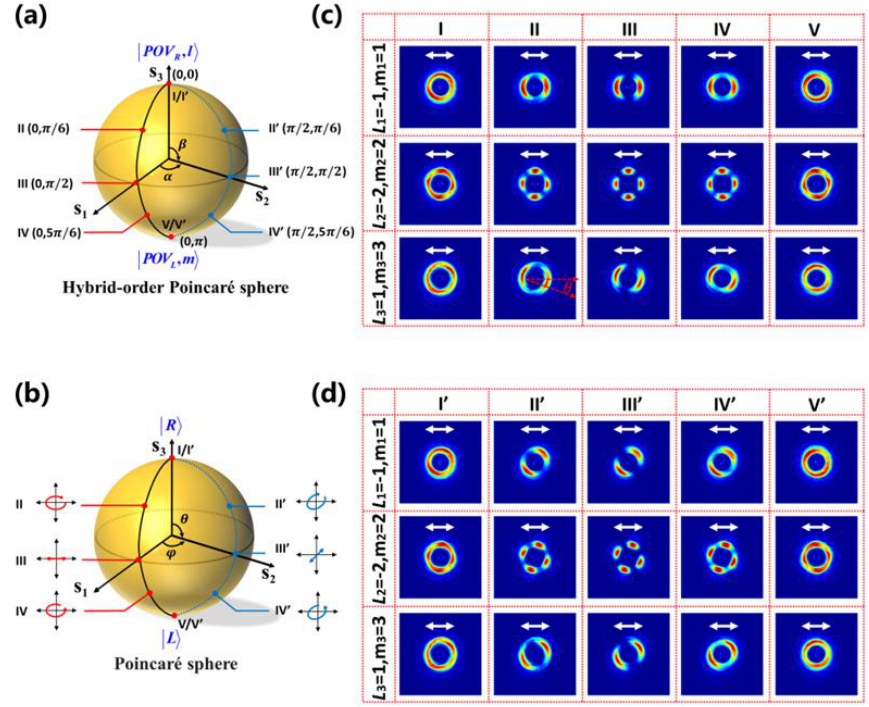
Figure 9. Characterization of the generated PPBs. ( a ) The selected states of PPBs are represented by red and blue points on the HyOPS with their coordinates. The phase difference between the two circular eigenstates of the selected blue dots is π/2. ( b ) Corresponding incident polarization states are represented by the red and blue points on the Poincaré sphere. ( c , d ) The simulated intensity profiles of the output PPBs correspond to the red points ( c ) and blue points ( d ) in ( a ) for three designed metasurfaces through a horizontal linear polarizer (depicted by the white double arrow).